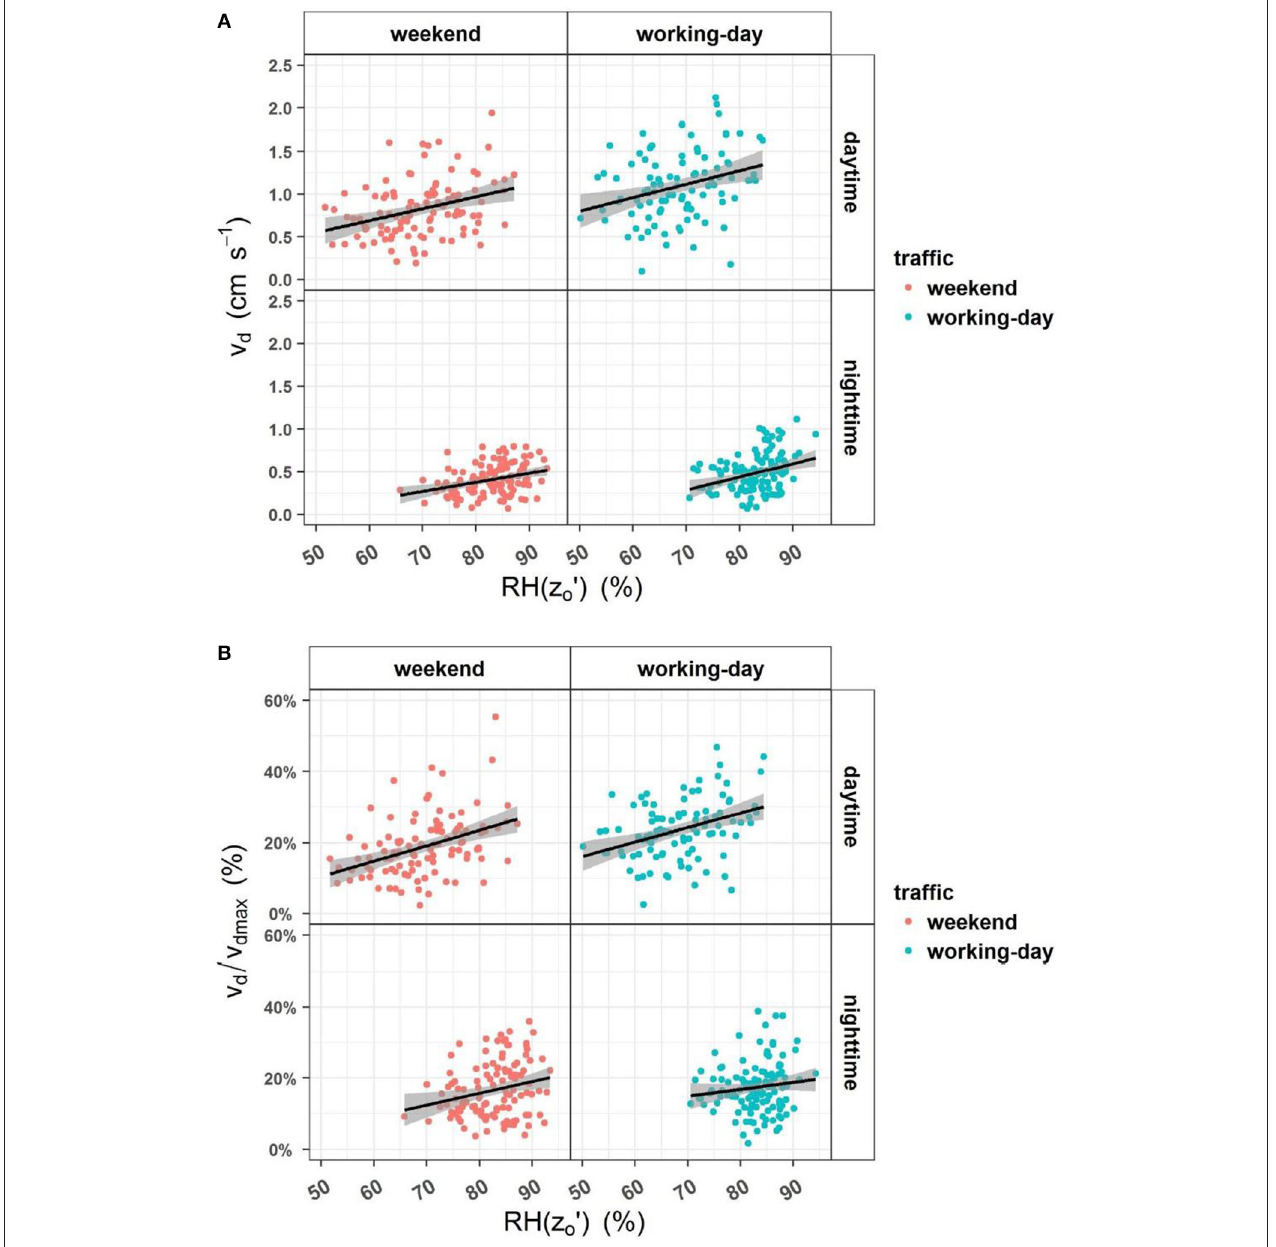
FIGURE 6 | Dependence of monthly (A) deposition velocity (cm s − 1 ) and (B) deposition efficiency (%) on relative humidity at the canopy surface (%), subdivided into day/nighttime and traffic